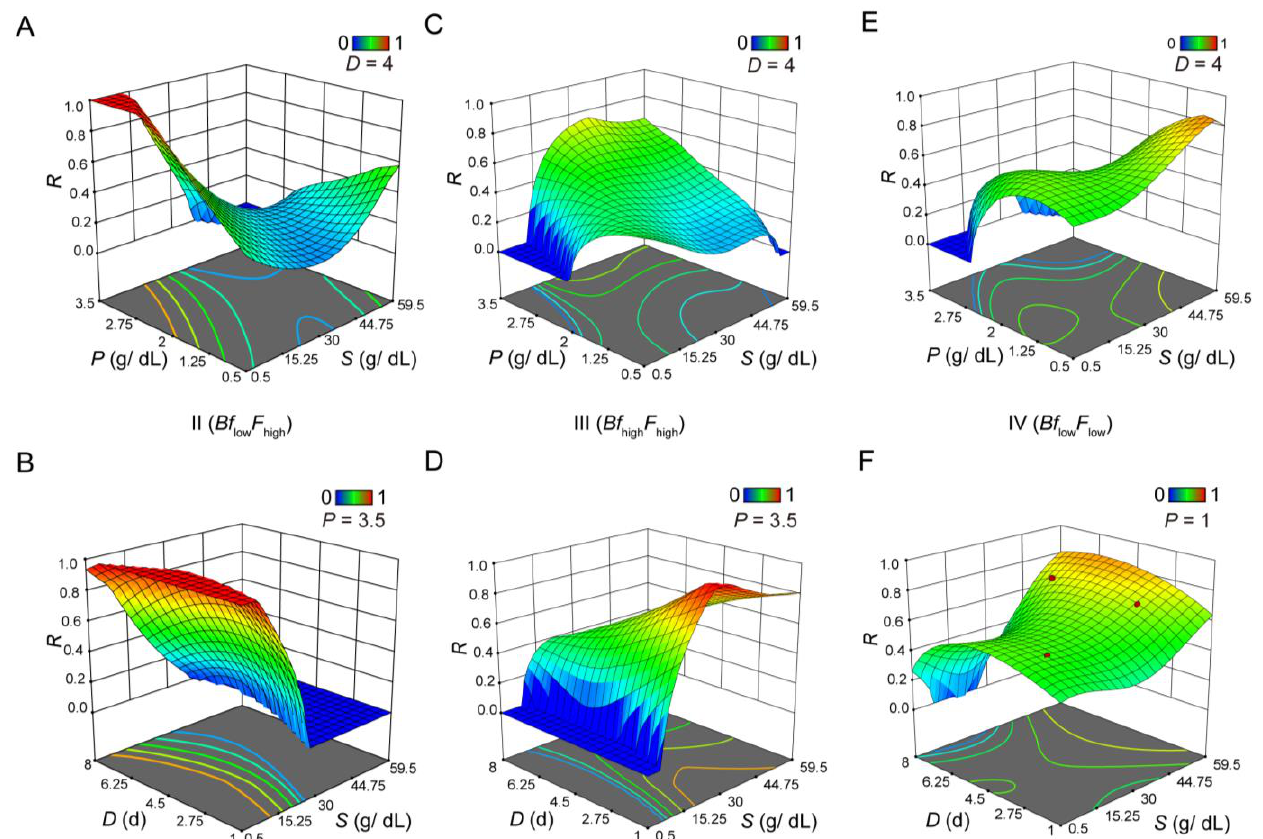
Figure 2. Integration analysis of Bf and F with different phenotype preference. Shown are integrated 3D surface plots showing R as a function of S - P ( A , C , E ) or S - D ( B , D , F ) under three different scenarios ( A – B for Scenario II, C – D for Scenario III, and D – F for Scenario IV). A high R value indicates a high desirability for the given scenario. For each panel, values for D or P are indicated.